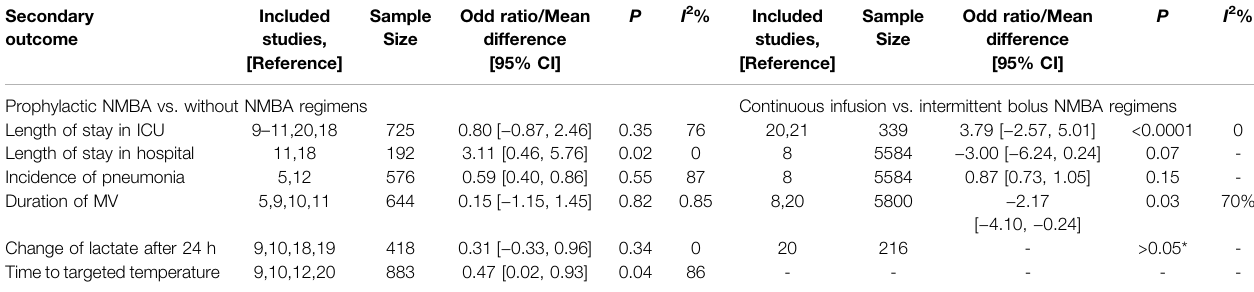
TABLE 3 | Secondary outcomes of the current systematic review and